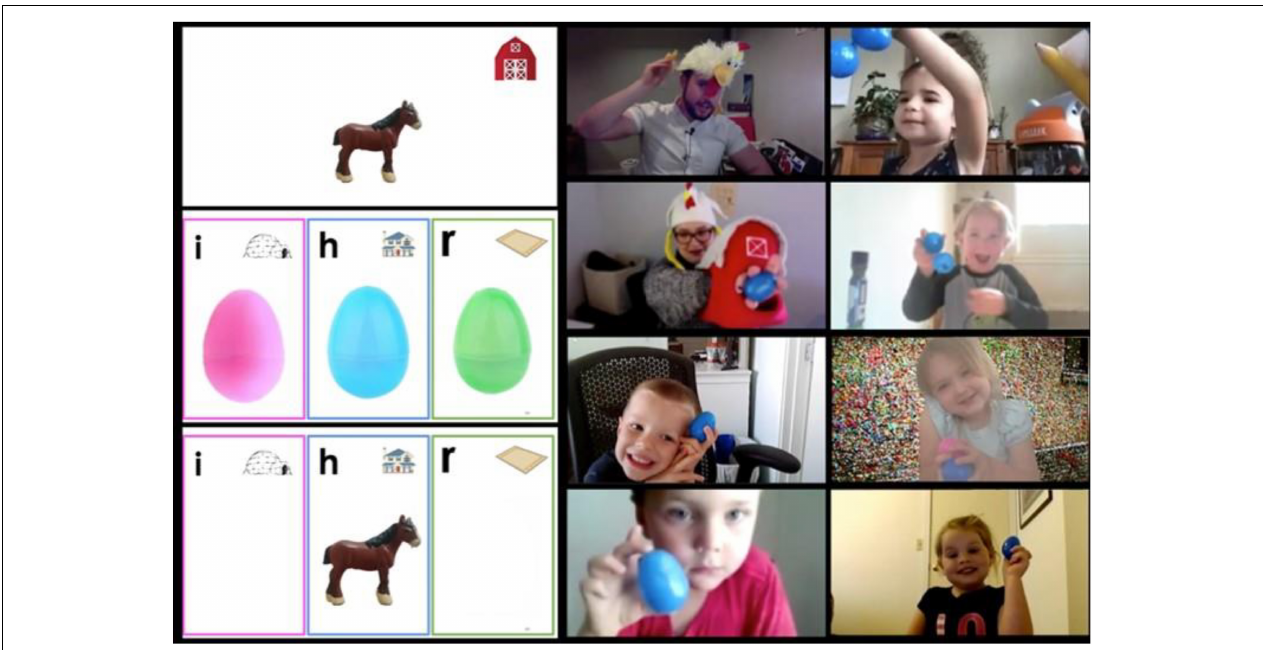
FIGURE 2 | A screenshot demonstrates an example of an integration activity. In this activity the two teachers (upper left) are wearing silly chicken hats to engage the children. With colorful plastic eggs from the supply box, the children pick which egg to hold up to show which letter the item starts with. On the left side, there are three photographs that the children see one after another: first, they see a picture of a horse, next they see a photograph that shows three letter options (“i” for “igloo,” “h” for “house,” and “r” for “rug”), and then finally after voting with their plastic eggs, the horse is revealed to belong to the letter “h.” On the right side, the children are holding up blue eggs because they could tell that the horse starts with the letter